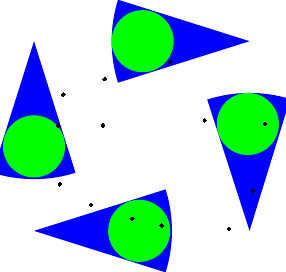
Figure 13: Screenshot of the MASON simulation toolkit. It de- picts the used camera setting as it was in use during the evalua- tion. The black dots mark the position of the points of interest as result of the pattern recognition